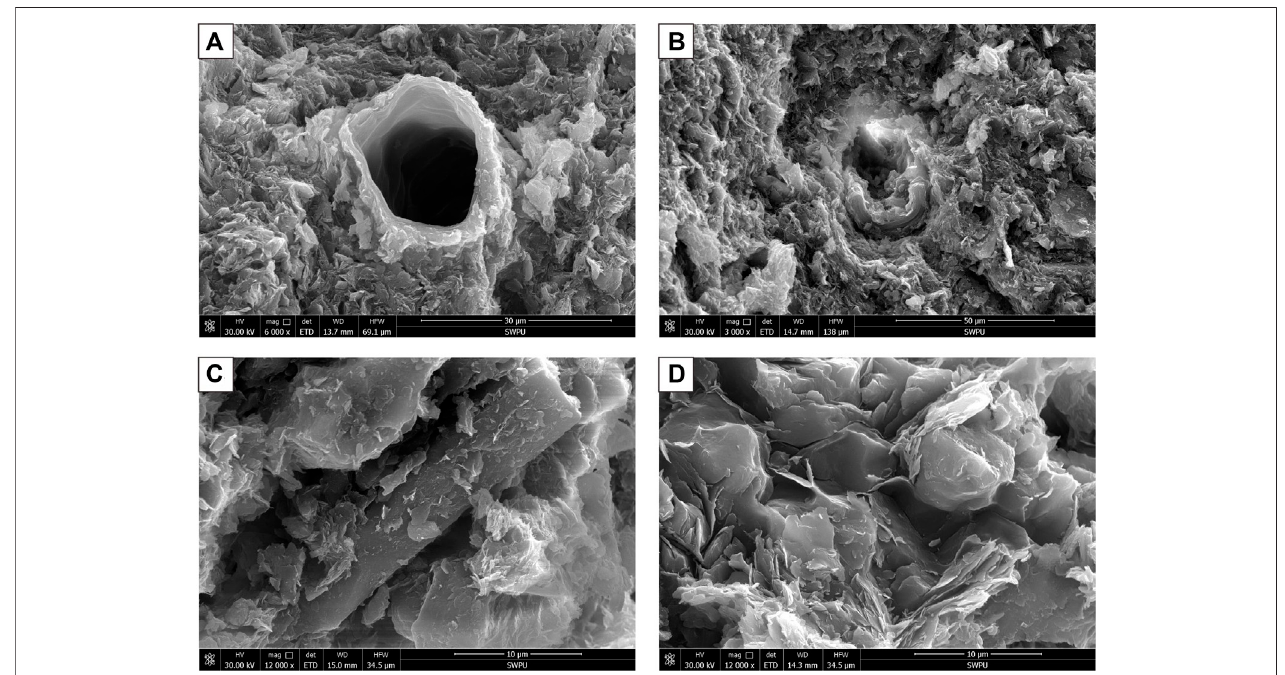
FIGURE 2 | SEM photos of quartzes in volcanic ash. (A – C) : hairline-like hollow quartzes. (D) : Aggregative quartzes.